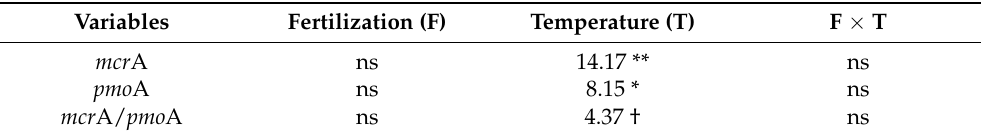
Table 3. F values for the effects of temperature and fertilization on the copies of mcr A, pmo A genes and mcr A/ pmo A ratio.